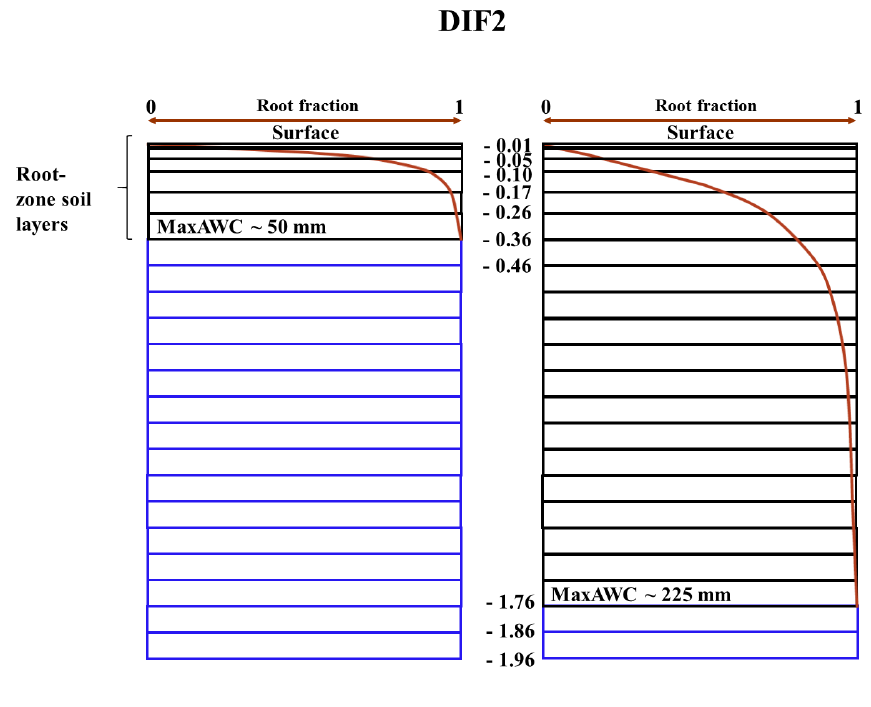
Figure 5. As in Fig. 4, except for the DIF2 experiment. Subroot soil layers are added (blue lines) down to a constant soil depth of 1.96m.